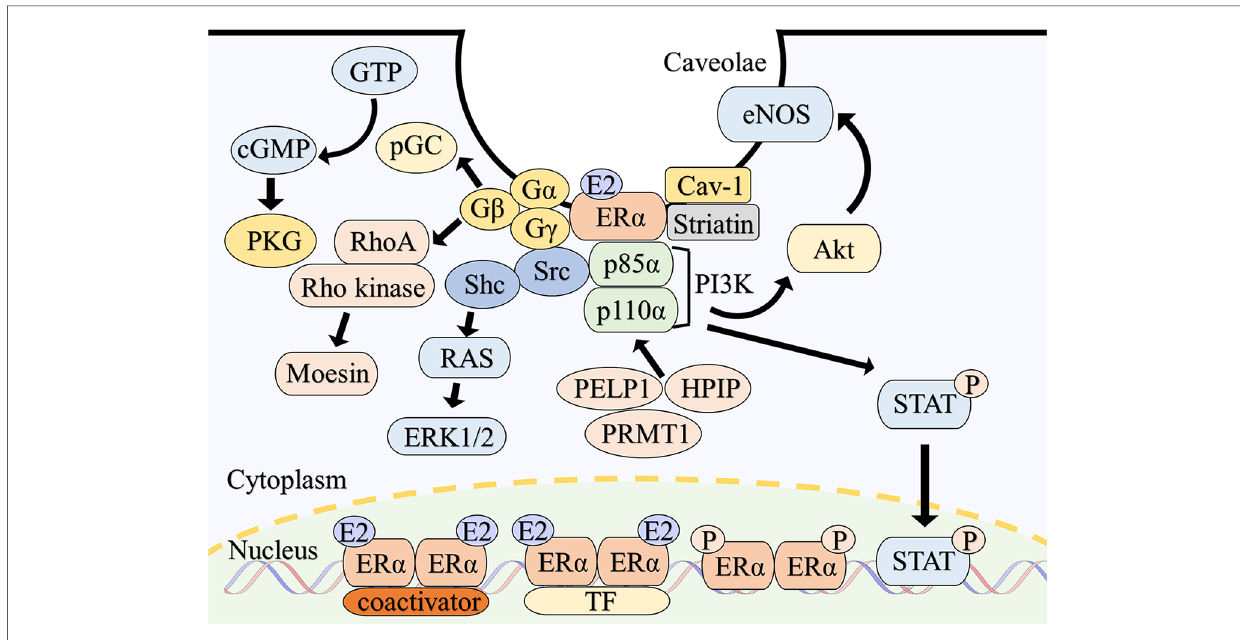
FIGURE 1 Overview of intracellular signaling of estrogen receptor α . Classically, E2-bound ER α dimerizes and translocate to the nucleus. ER α directly binds to estrogen response elements of the target genes with coactivators and modulates gene expressions. ER α also binds to DNA indirectly in association with other transcription factors. Phosphorylation of ER α also enhances transcriptional activity. A subpopulation of ER α is localized to the caveolae of the plasma membrane through the interaction with caveolin-1 and striatin. ER α on the plasma membrane assembles a functional complex with associated proteins such as G proteins, Src and PI3K, resulting in the rapid activation of multiple intracellular signaling. Abbreviations; Akt, protein kinase B; Cav-1, caveolin-1; cGMP, cyclic guanosine monophosphate; eNOS, endothelial nitric oxide synthase; E2, estradiol; ERK, extracellular signal- regulated kinase; ER α , estrogen receptor α ; GTP, guanosine triphosphate; HPIP, hematopoietic PBX-interacting protein; PELP1, proline-, glutamic acid- and leucine-rich protein 1; pGC, particulate guanylate cyclase; PI3K, phosphatidylinositol-3 kinase; PKG, cGMP-dependent protein kinase; PRMT1, protein arginine methyltransferase 1; P, phosphorylation; Shc, src homology and collagen; STAT, signal transducer and activator of transcription; TF, transcription